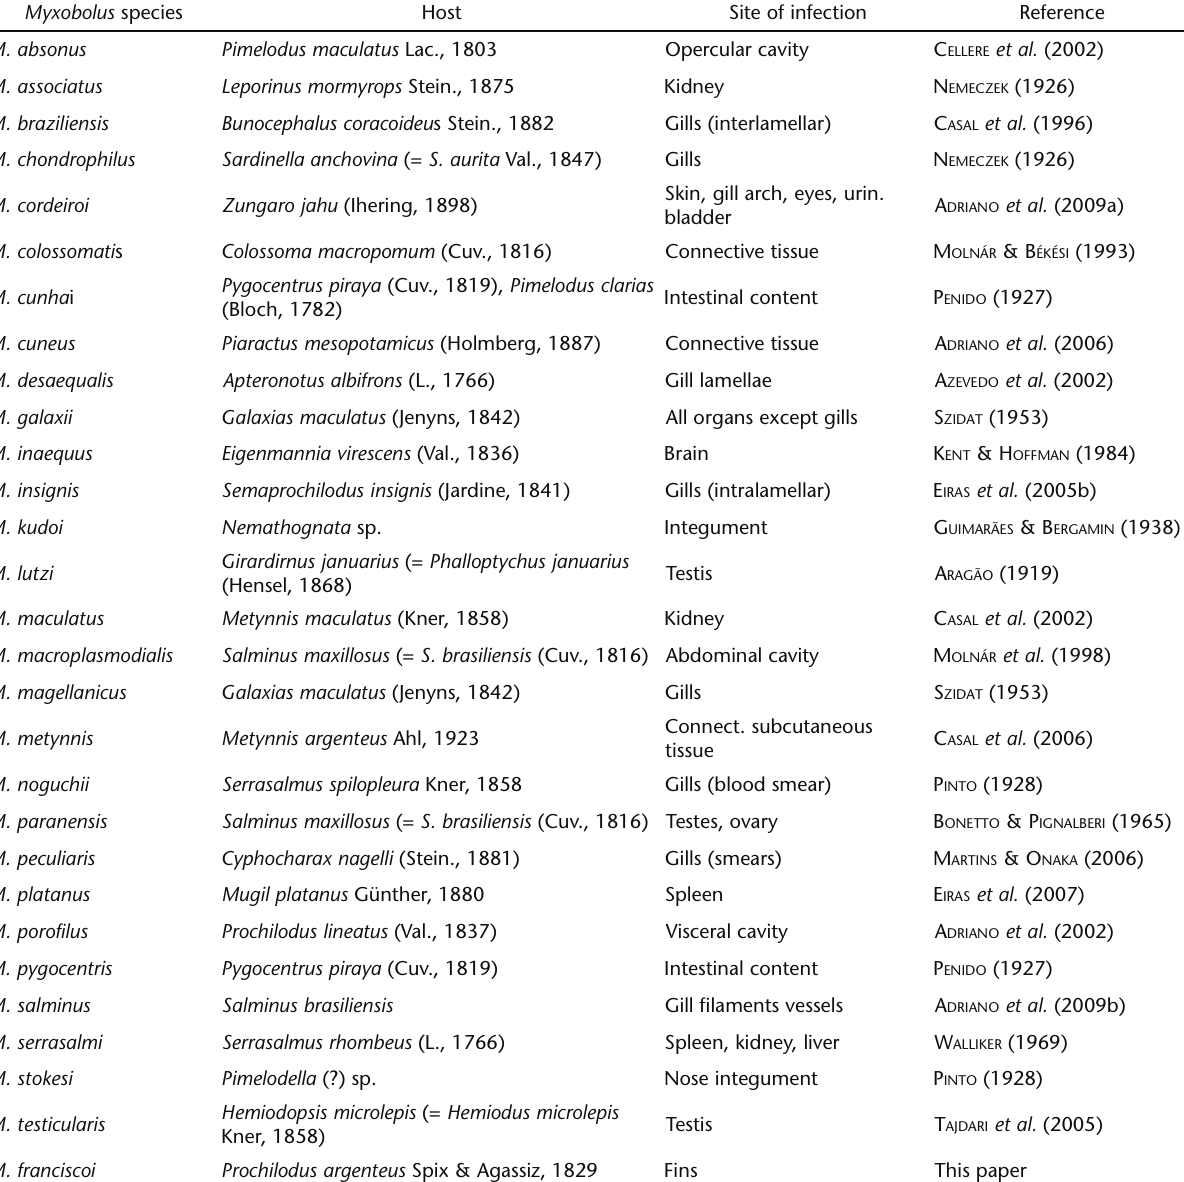
Table II. References for features listed in table